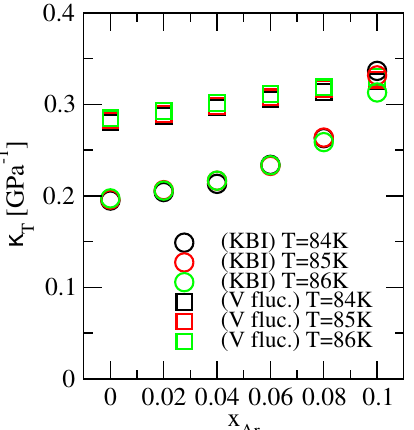
Figure 13. Isothermal compressibility from KBIs (circle) and from volume fluctuations